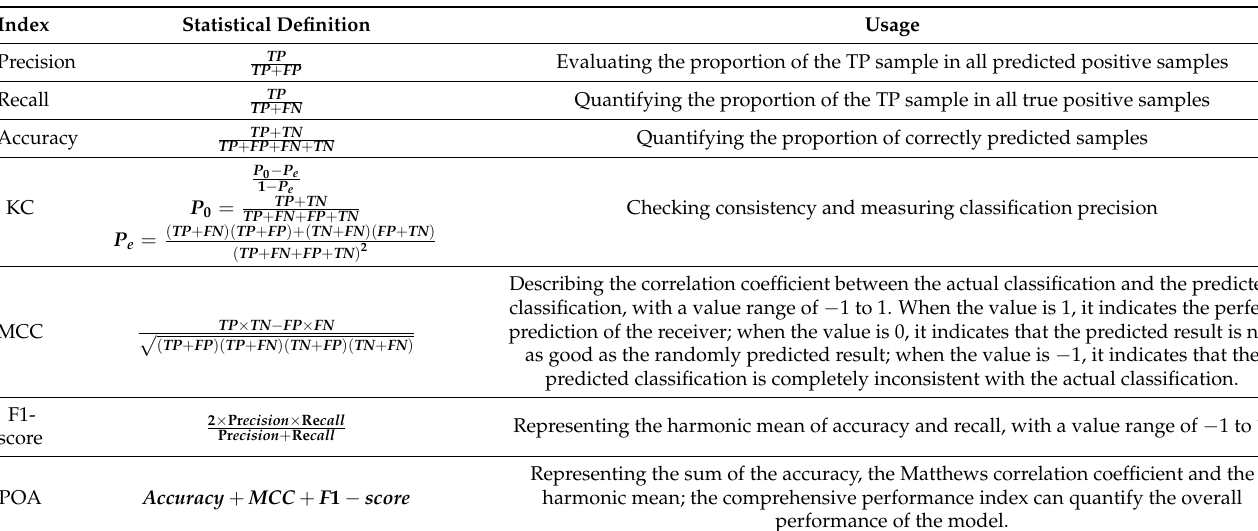
Table 4. Description of characteristics of statistical indexes based on confusion